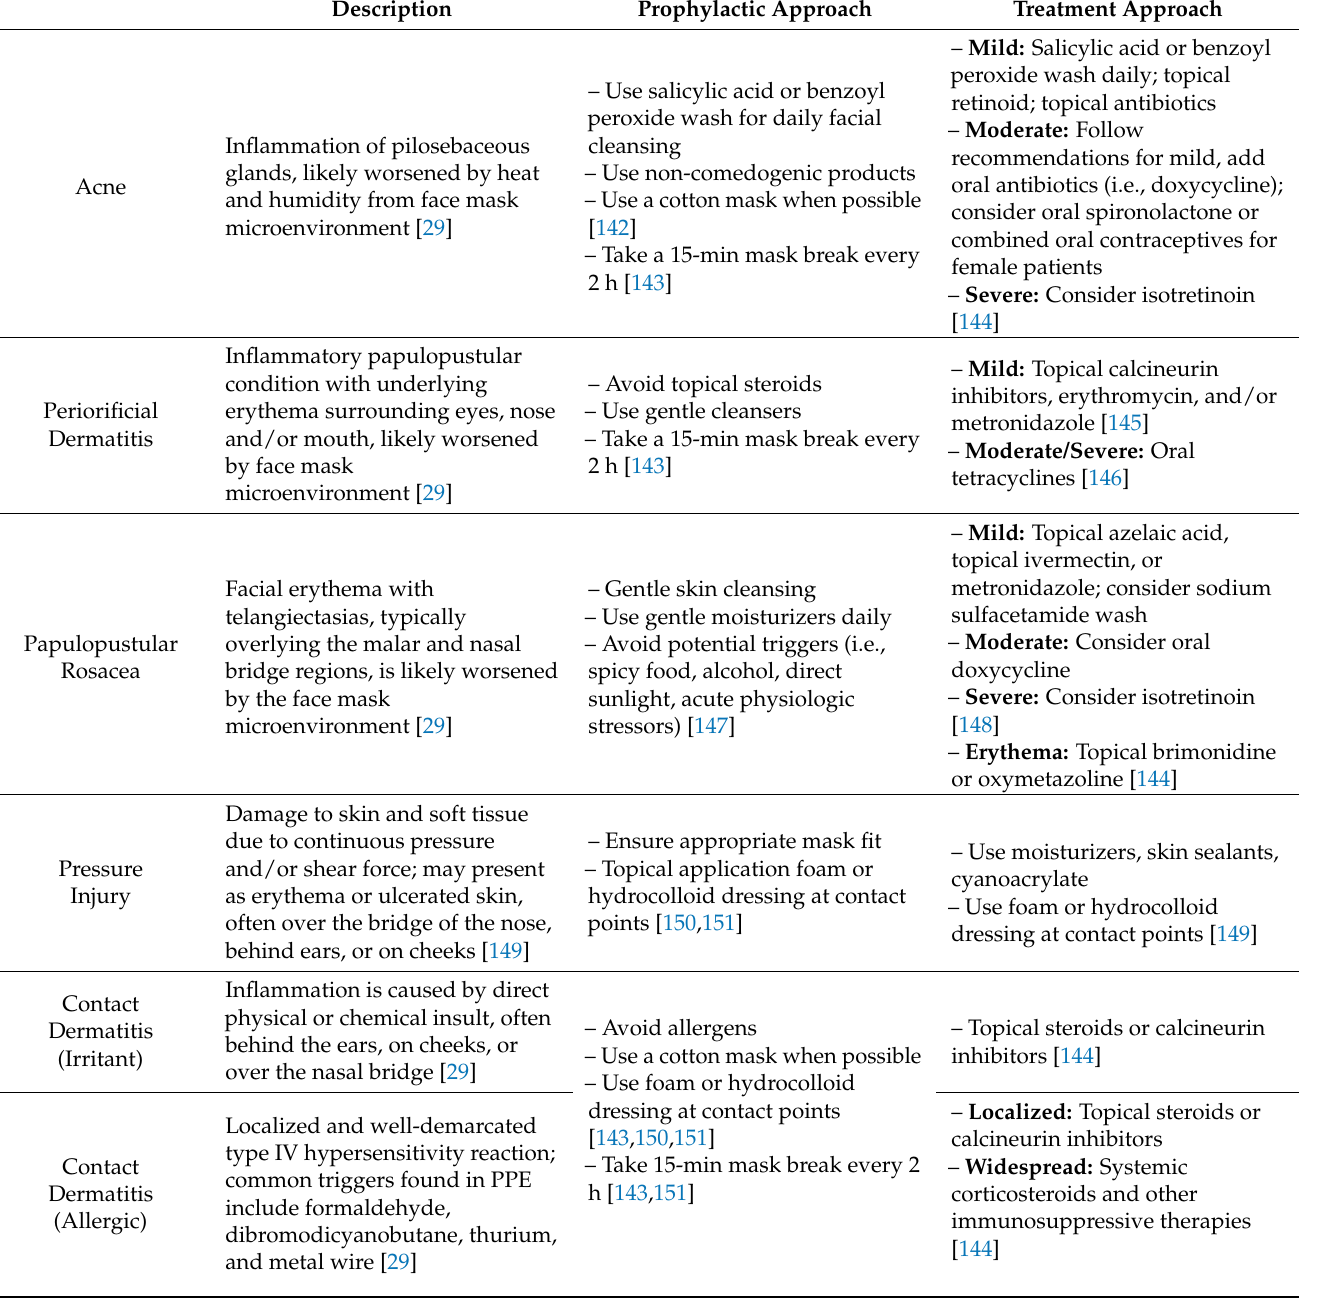
Table 3. PPE-related Skin Conditions and Treatment